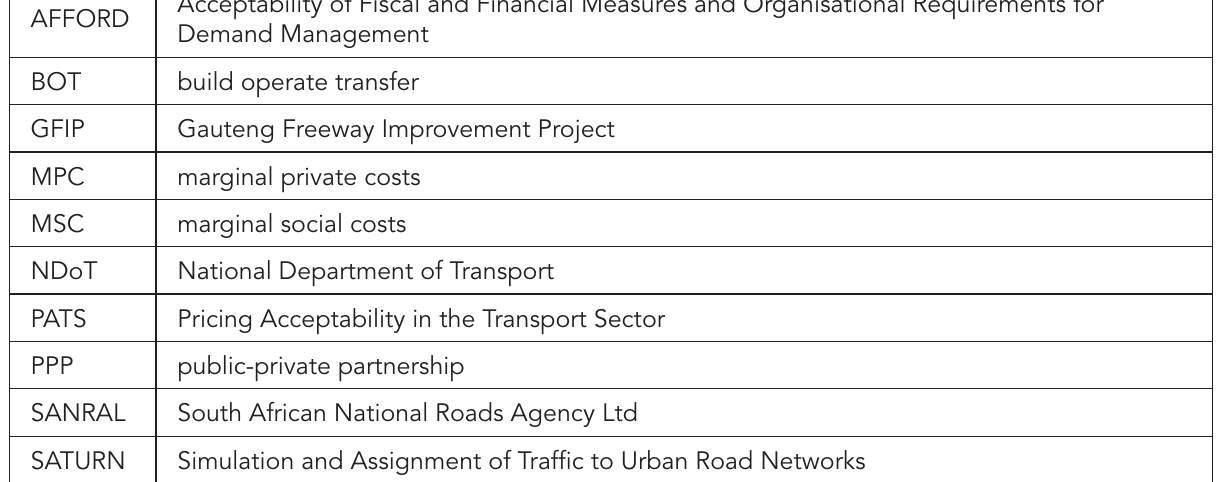
Acceptability of Fiscal and Financial Measures and Organisational Requirements AFFORD